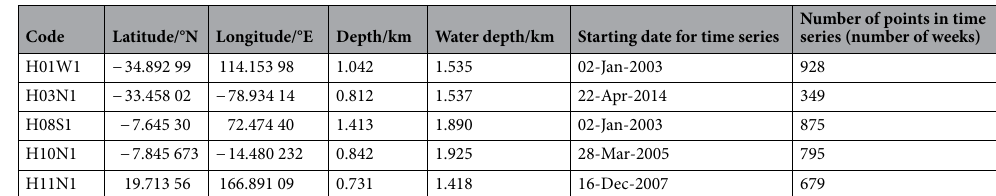
Table 1. Information about the hydrophones H01W1 at the CTBT station at Cape Leeuwin, H03N1 at Juan Fernandez Islands, H08S1 at Diego Garcia Island, H10N1 at Ascension Island, and H11N1 at Wake Island.